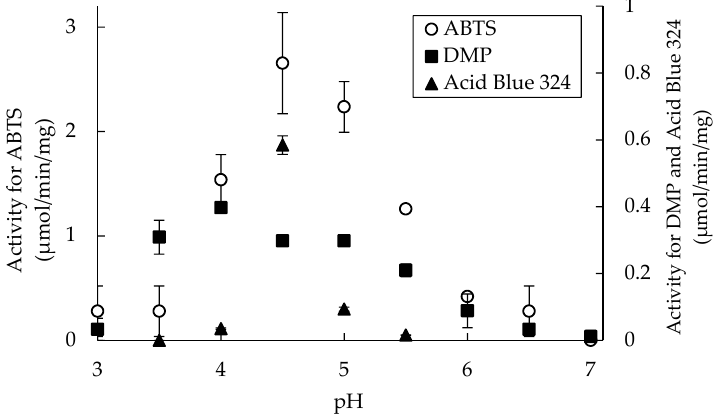
Figure 3. Optimal pH for the peroxidase activity of SaDyP1. Peroxidase activities against ABTS and DMP were measured between pH 3 and 7. Decolorizing activities against Acid Blue 324 were measured between pH 3.5 and 5.5 ( n = 3). Open circle, ABTS; closed square, DMP; closed triangles, Acid Blue 324.